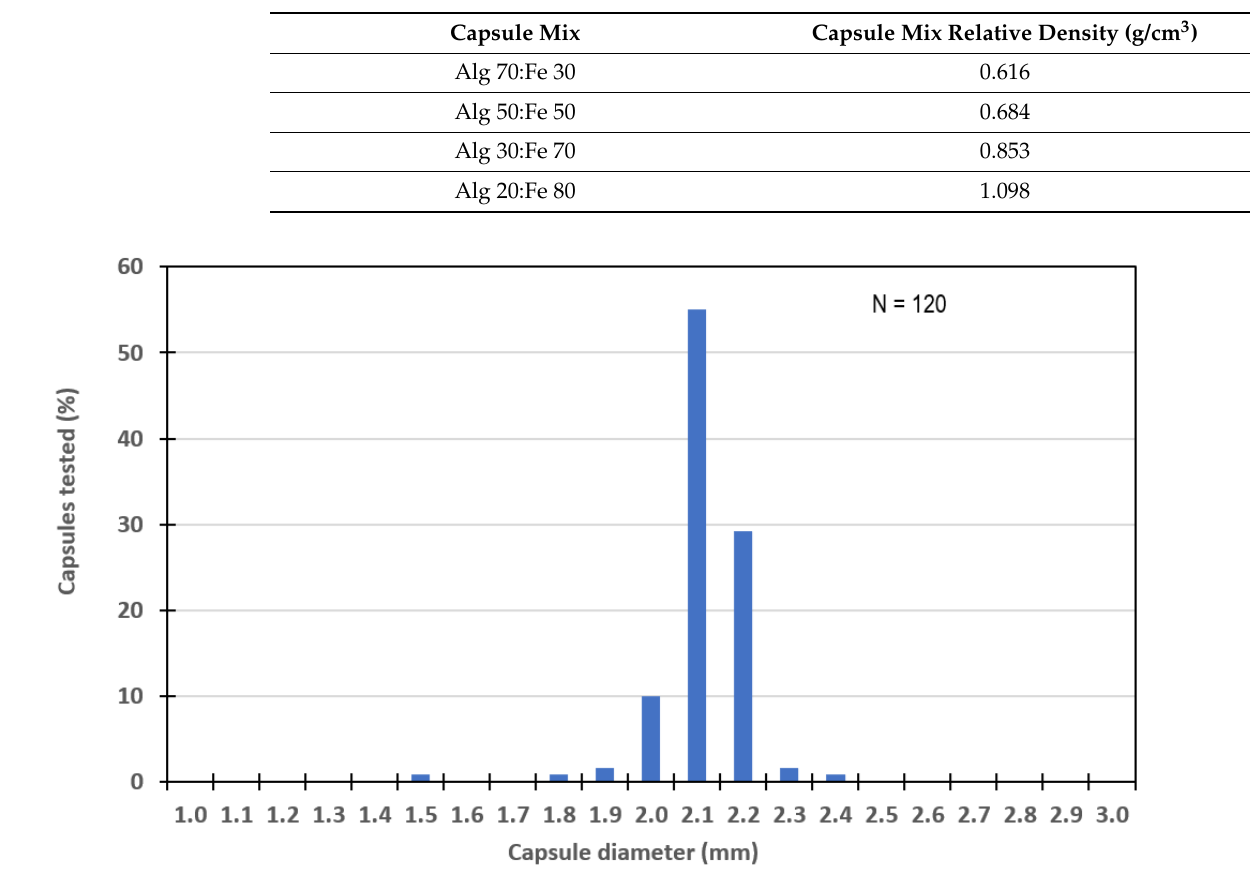
Figure 8. Capsule size distribution.